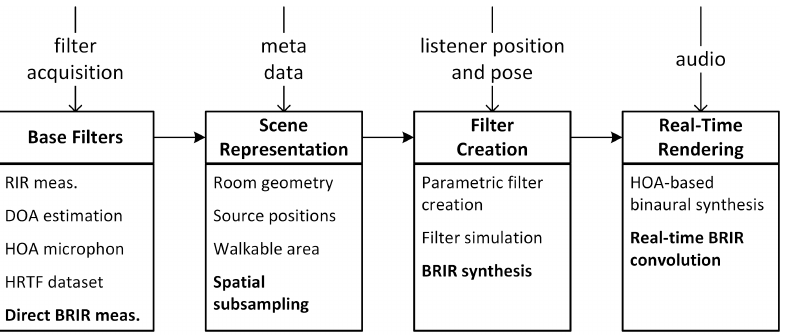
Figure 1. Basic block diagram of a position-dynamic binaural synthesis system showing differ- ent functional blocks with examples of realization. Bold marked realizations are related to the approaches